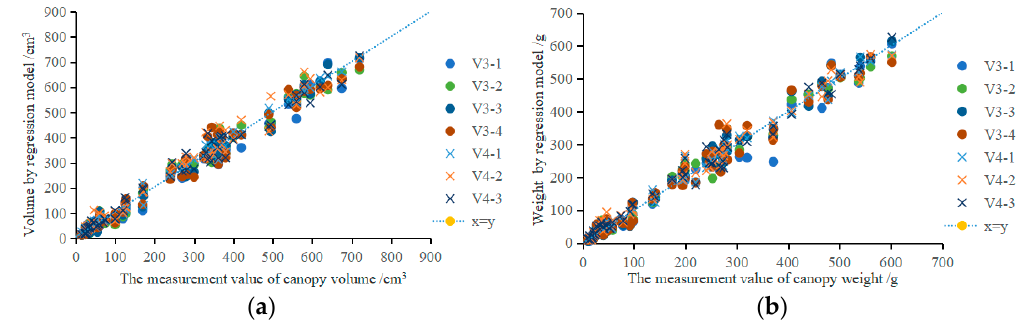
Figure 14. The results of canopy volume and fresh weight: ( a ) calculated and measured values of canopy volume; ( b ) calculated and measured values of canopy fresh weight.